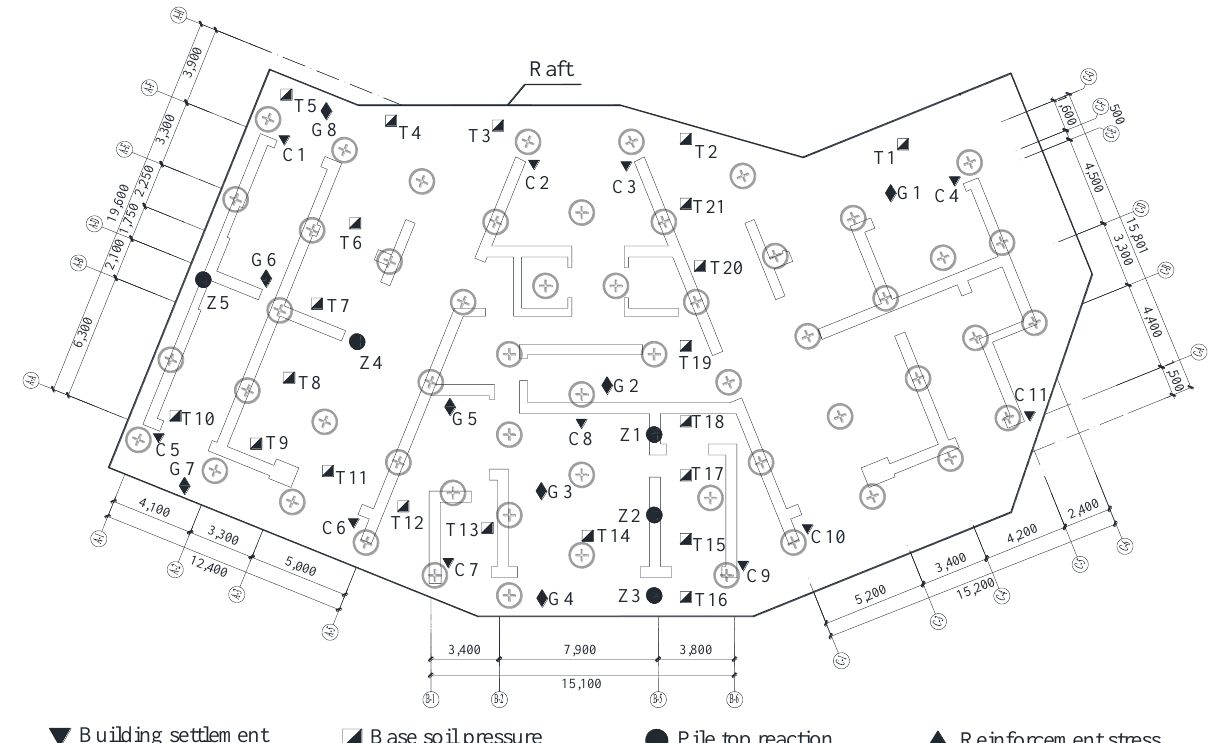
Figure 16. Arrangement of monitoring points .